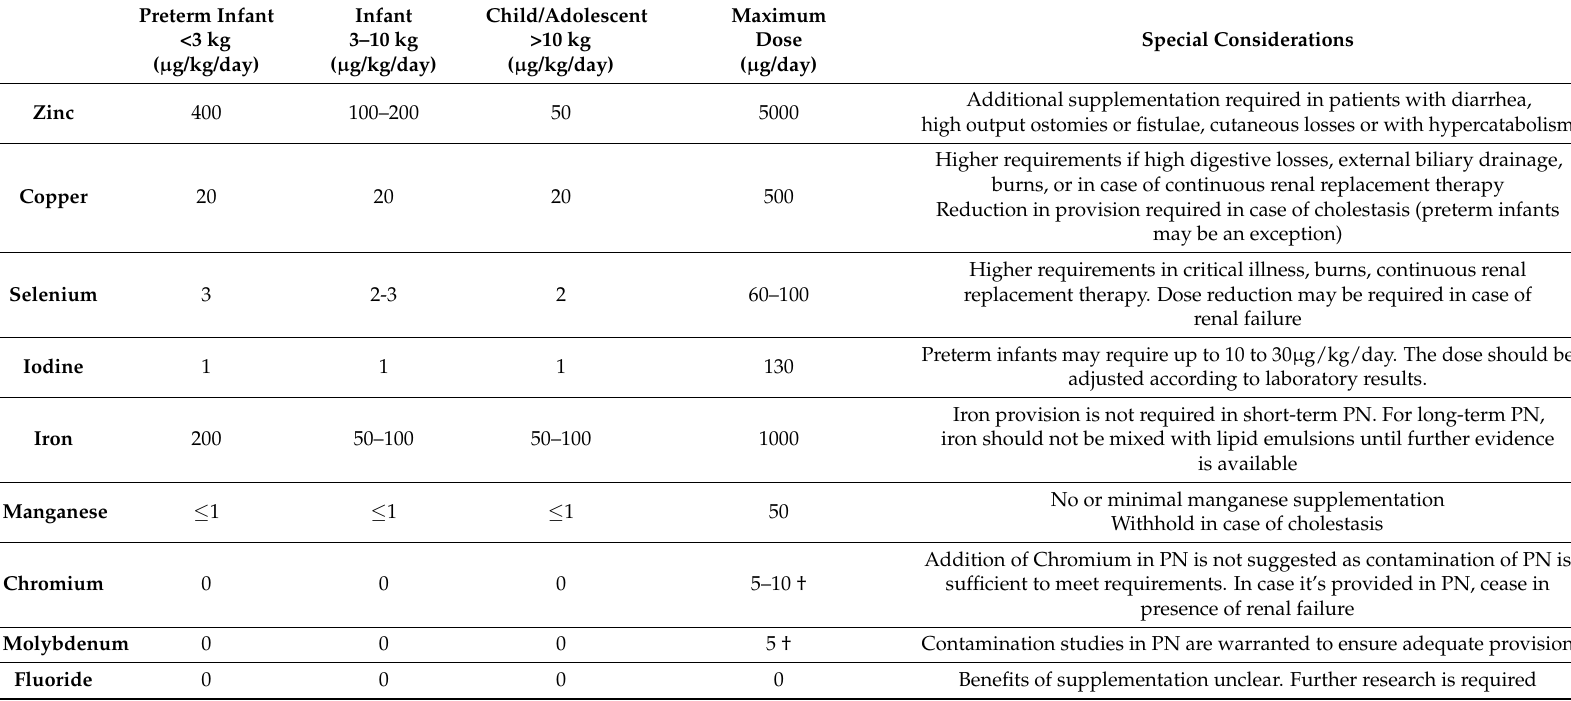
Table 3. Proposed 2018 AuSPEN Guidelines for pediatric trace element provision in parenteral